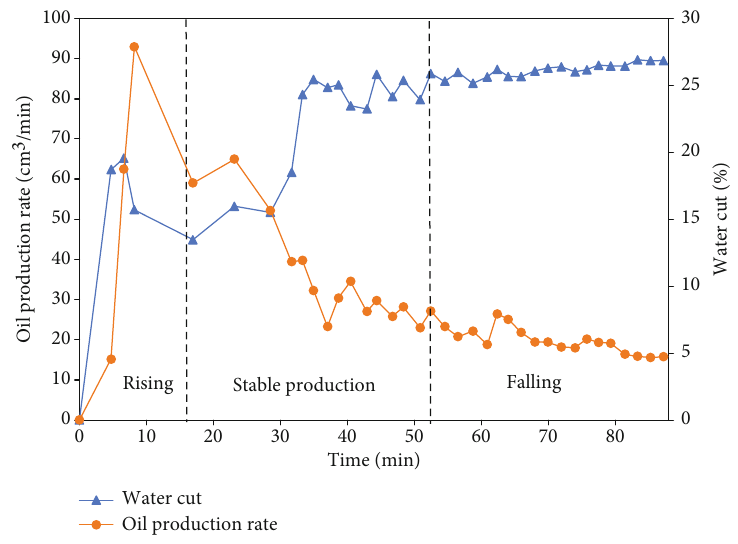
Figure 7: The oil production rate and water cut of 220 ° C saturated SAGD.